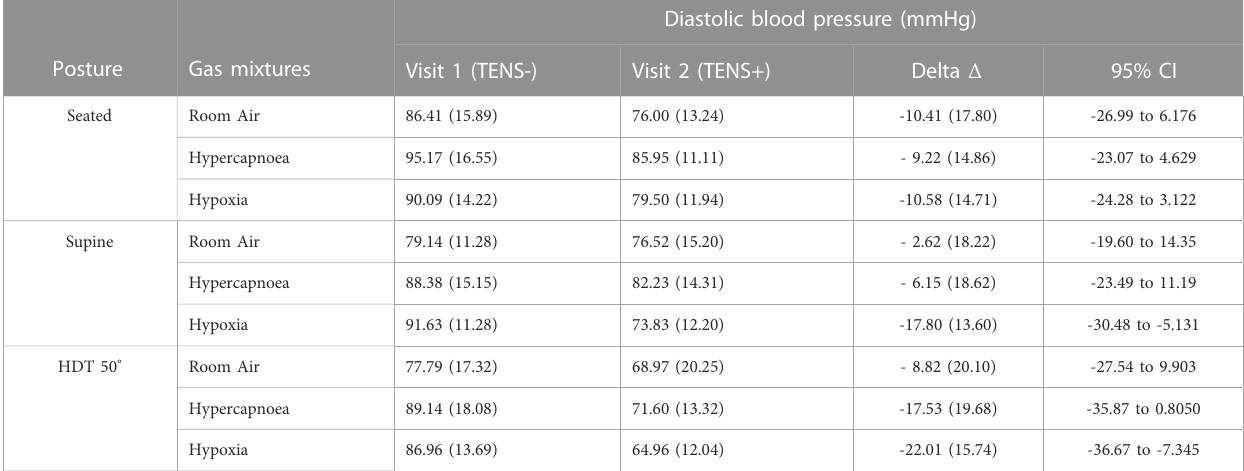
TABLE 2 Diastolic blood pressure with and without electrical stimulation in seated, supine and HDT postures. Data are presented as mean (SD). HDT, head down tilt. TENS-, electrical current off. TENS + electrical current turned on. 95% CI, 95% con fi dence interval.